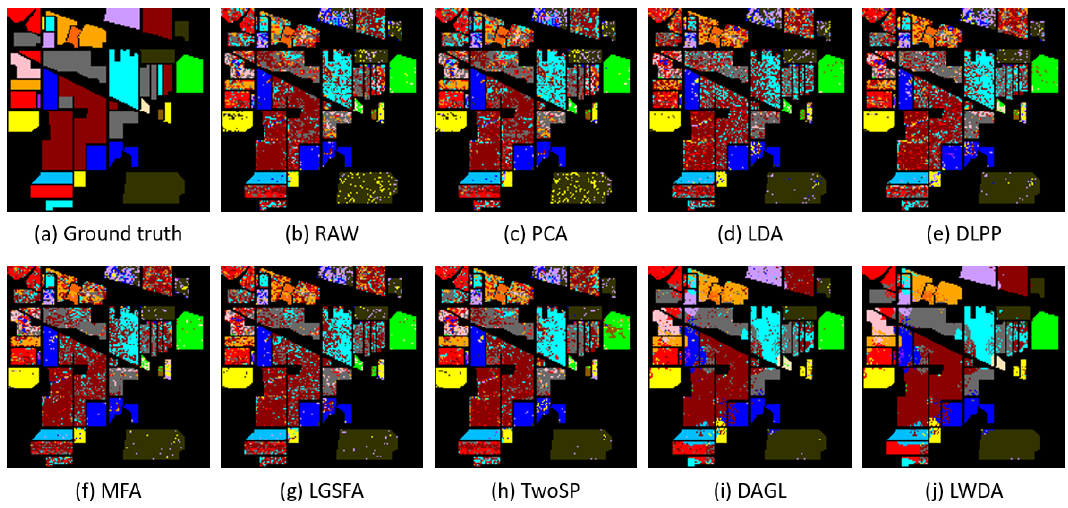
Figure 2. Classification maps of different dimensionality reduction methods with NN classifier on the Indian Pines dataset ( τ = 0.05). ( a ) Ground truth; ( b ) original raw spectral feature (RAW); ( c ) principal component analysis (PCA); ( d ) linear discriminant analysis (LDA); ( e ) discrimination- information-based locality preserving projection (DLPP); ( f ) marginal Fisher analysis (MFA); ( g ) local geometric structure Fisher analysis (LGSFA); ( h ) two-stage subspace projection (TwoSP); ( i ) discriminant analysis with graph learning (DAGL); ( j ) proposed locally weighted discriminant analysis (LWDA).